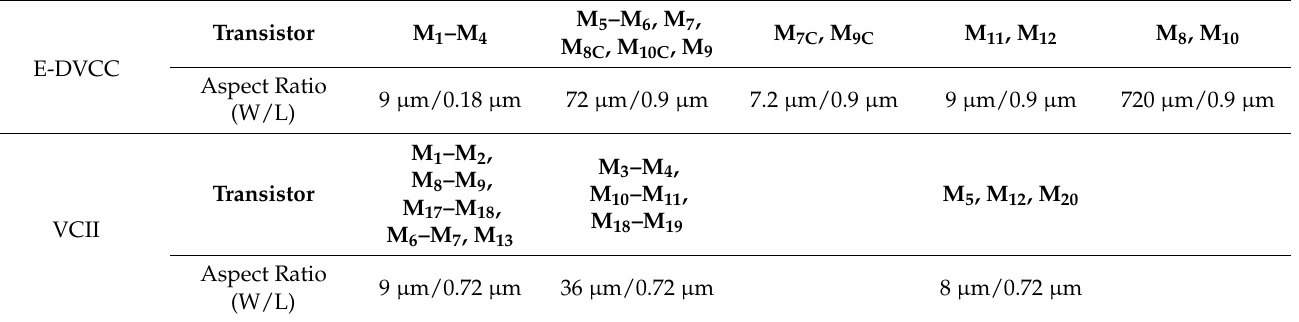
Table 1. The used transistors aspect ratios.